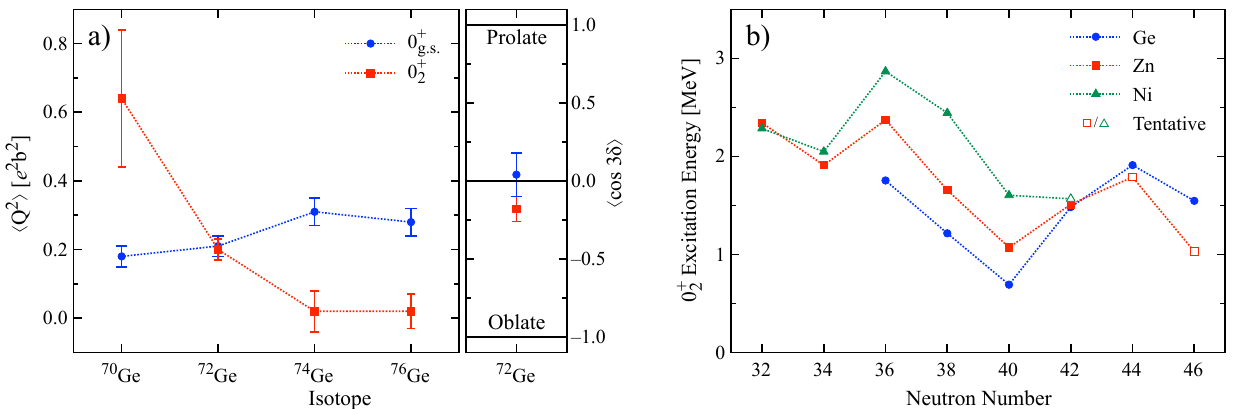
and cos3 δ quantities for the 0 + g.s. and 0 + states in Ge isotopes. Data are taken from [21,23–26]. Figure 3. ( a ) Q 2 2 (cid:104) (cid:105) (cid:104) (cid:105) ( b ) Systematics of excitation energies for the 0 + states in Ge, Zn and Ni isotopes from neutron number N = 32 to N = 46. 2 Tentative spin assignments are shown by open symbols. Data are taken from the ENSDF database [34–37]. See text for